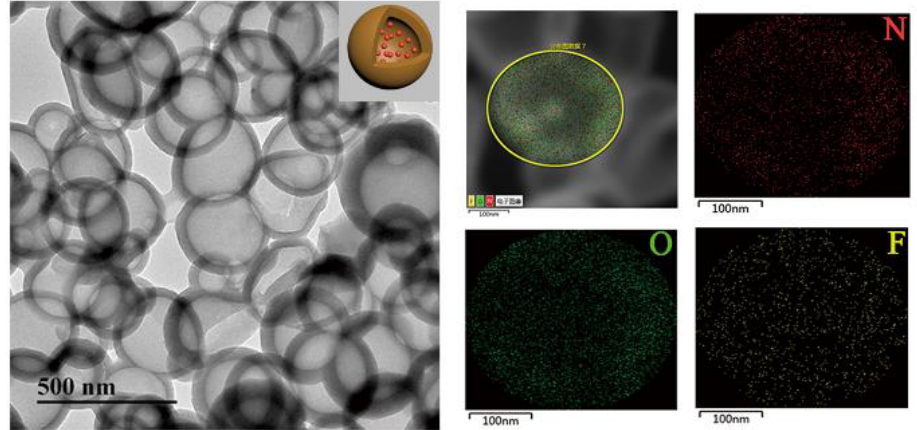
Figure 4. TEM-EDS images of CIP-PDA. (inset: a schematic illustration of CIP-PDA). CIP-PDA: ciprofloxacin (CIP)-loaded PDA NCs.